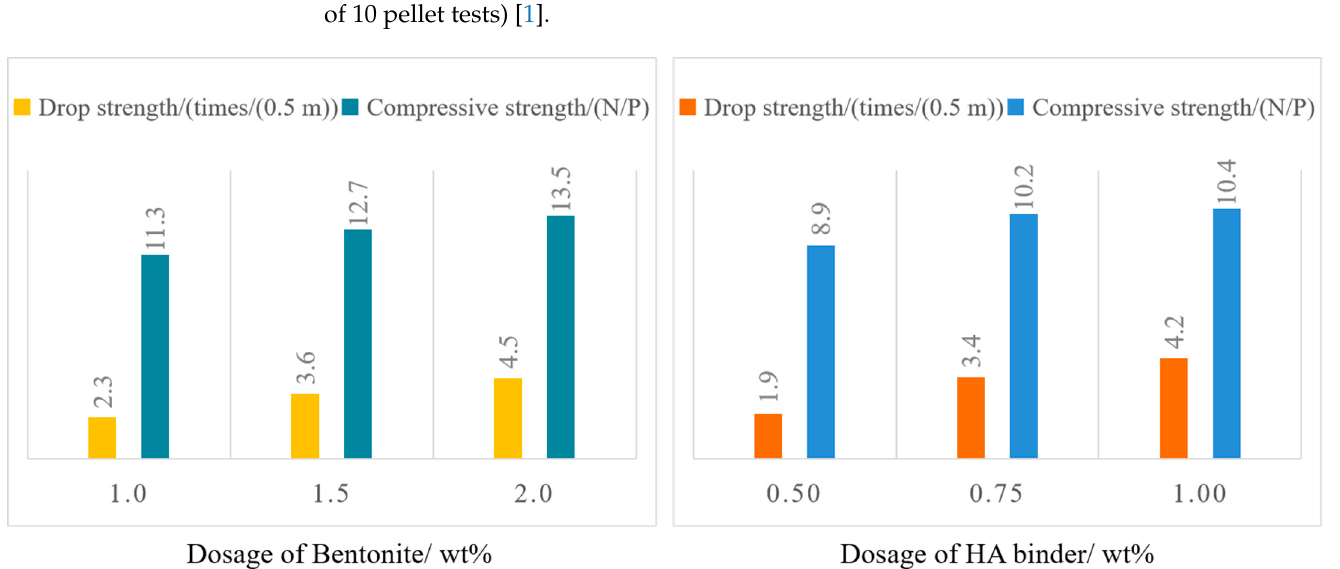
Figure 4. Effect of binder amounts on the qualities of VTM green pellets.